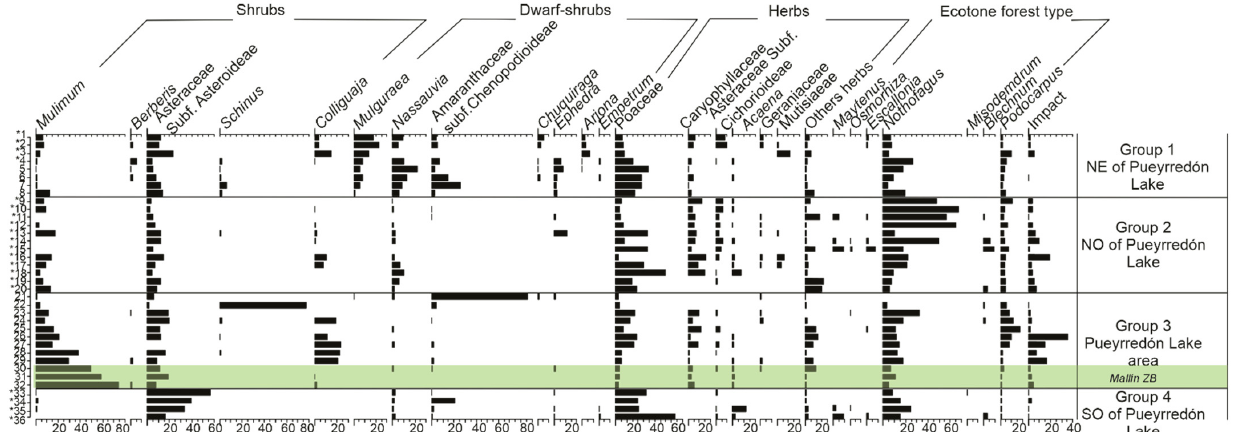
Figure 2. Pollen diagram in percentages (%) of surface samples at regional scale. New samples in respect to [9,22] are shown with asterisk.